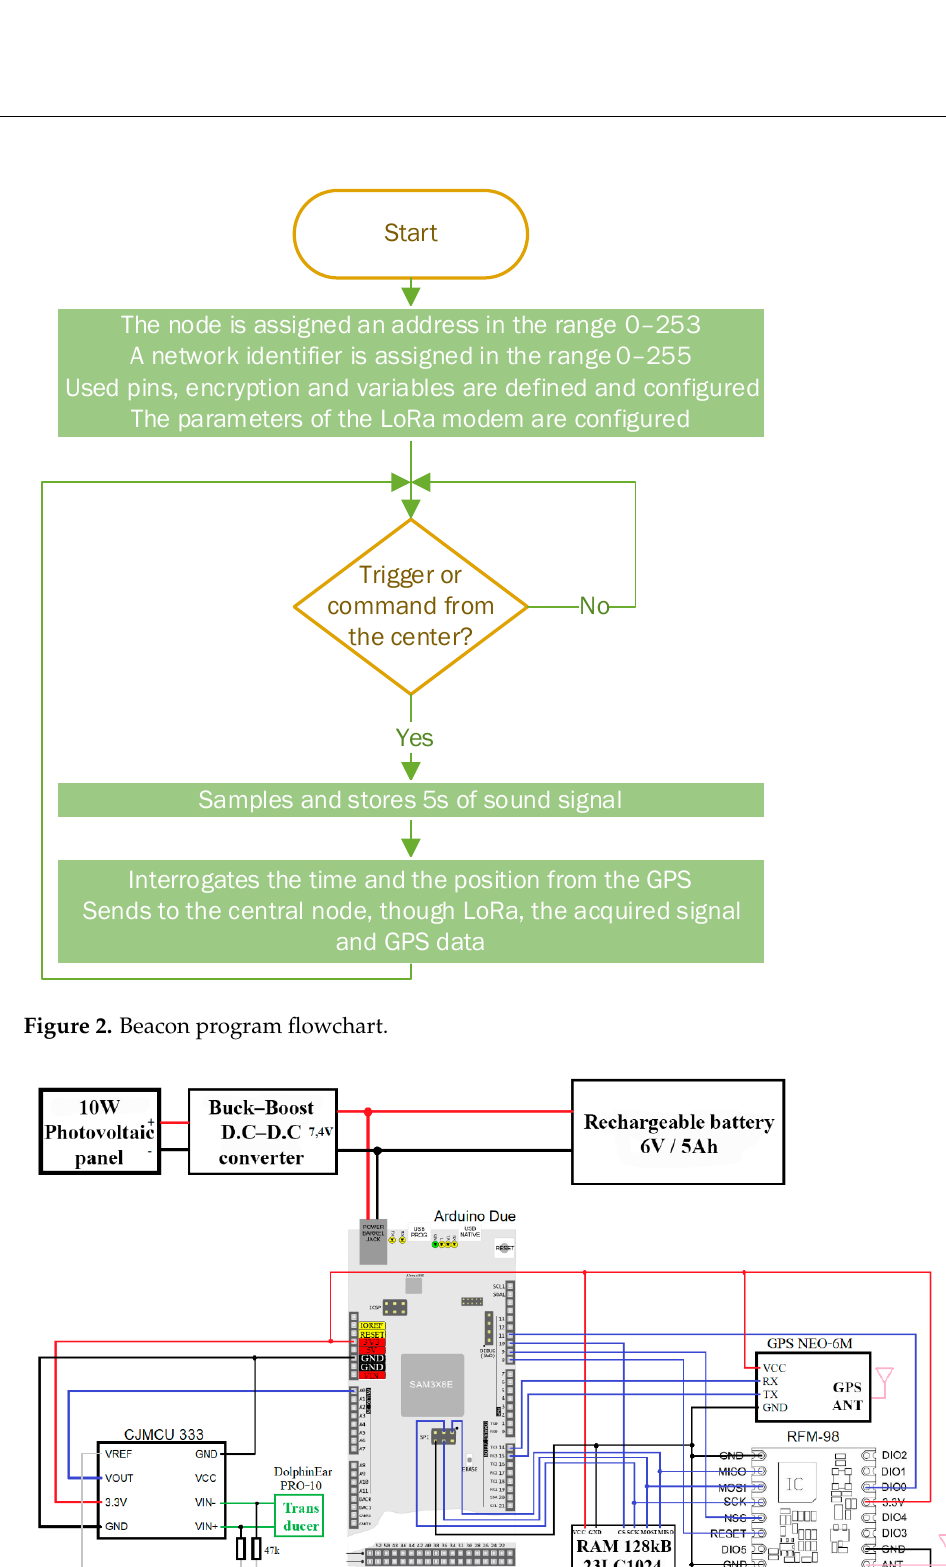
Figure 3. Electrical diagram of a beacon.